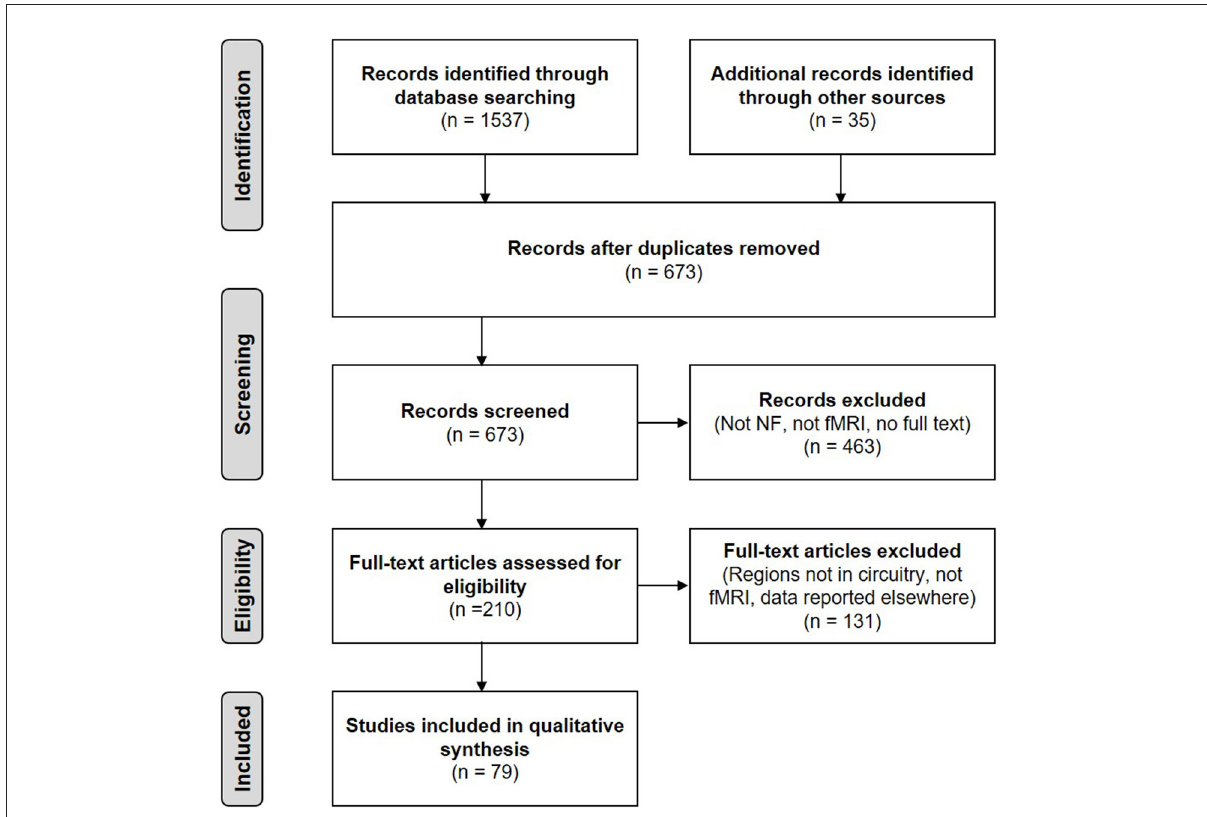
FIGURE2 PRISMA flow diagram of the literature search (adapted from Moher et al.,